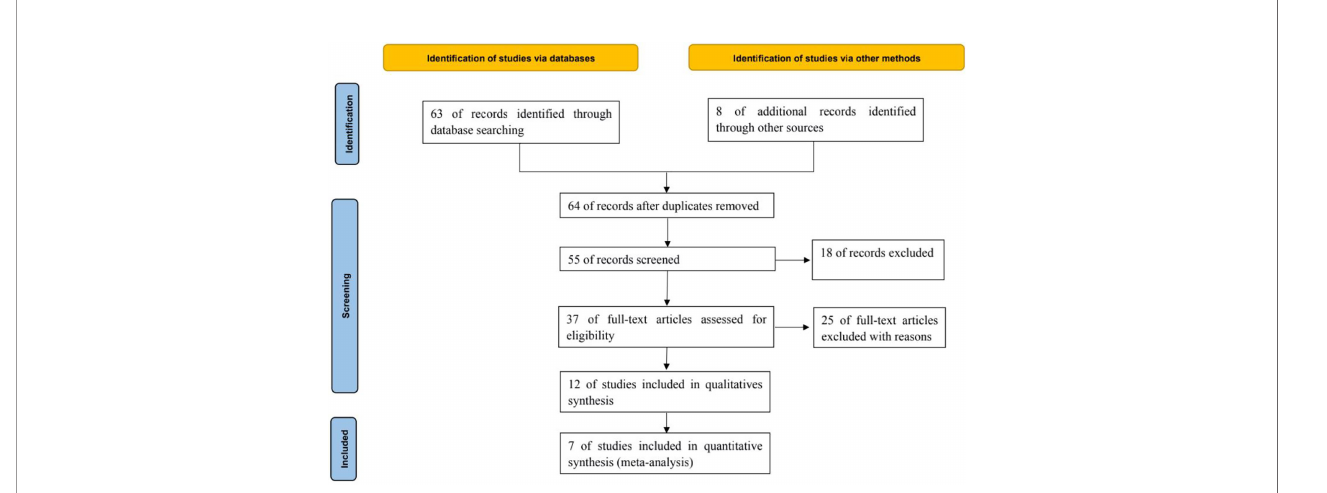
FIGURE 1 | PRISMA Flow chart of article